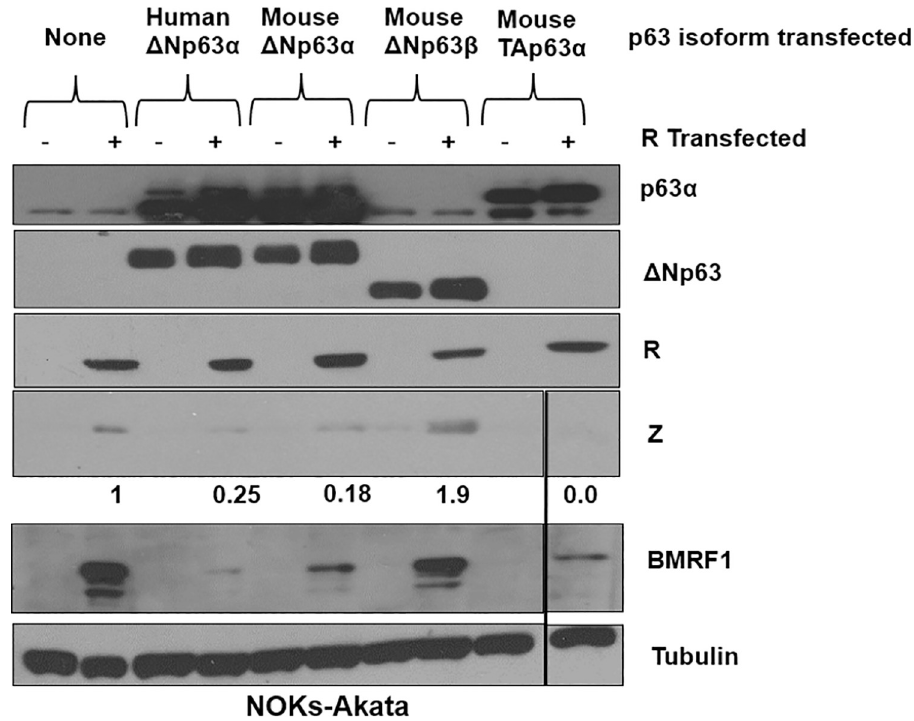
Fig 7. The C-terminus of p63 protein is required for the ability to inhibit R-mediated lytic reactivation. NOKs- Akata cells were transfected with or without an R expression vector in the presence or absence of various different co- transfected p63 isoform vectors, including the human Δ Np63 α protein, the mouse Δ Np63 α protein, the mouse Δ Np63 β isoform (homologous to Δ Np63 α but lacking 121 amino acids at the C-terminal domain), or the mouse TAp63 α isoform (which is identical to Δ Np63 α except for the addition of an N terminal transactivating domain). Two days after transfection, immunoblots were performed to assess expression levels of the Z, R, BMRF1, p63 protein isoforms, and tubulin as indicated. The quantification of Z protein expression was determined through ImageJ, normalized to tubulin, with the R alone condition set as 1. The black lines show where irrelevant lanes were removed; the original western blots used to construct this figure are shown in supplemental Fig 7. This experiment is representative of two independent biological